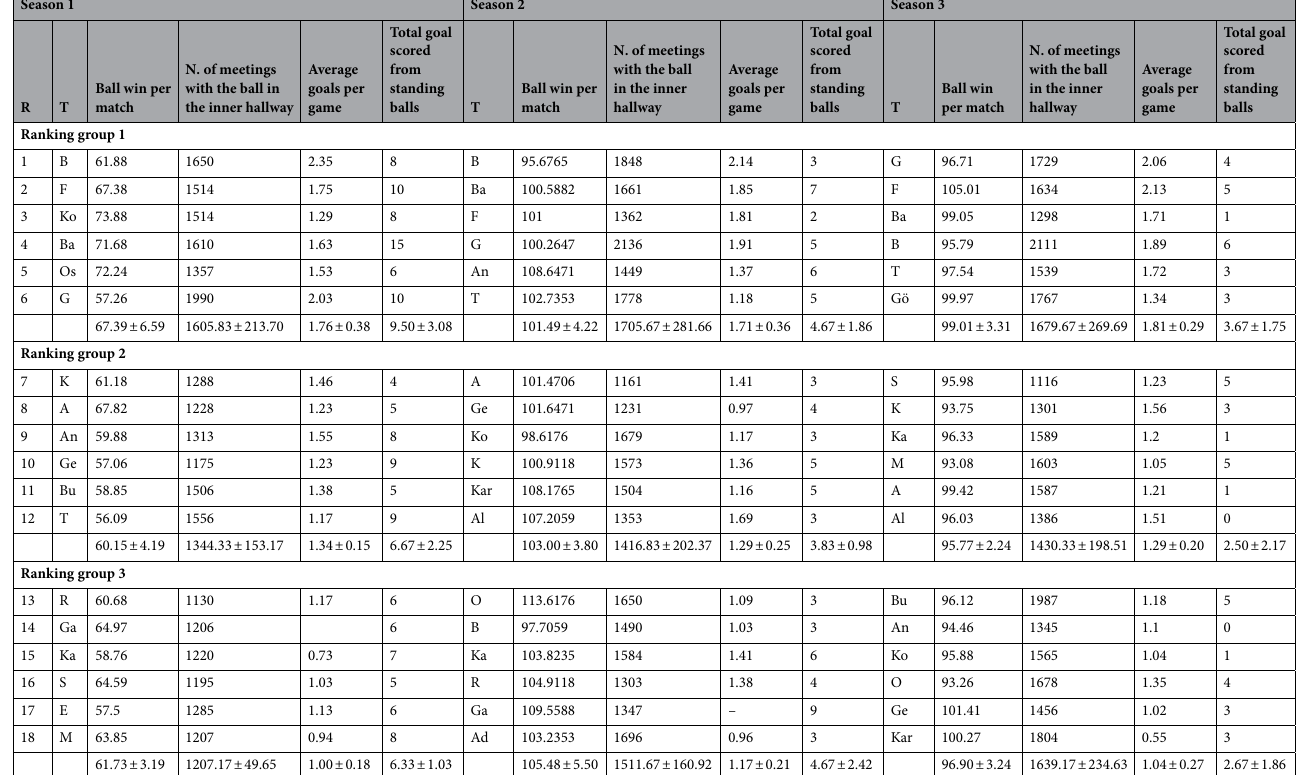
ranking group and season condition, F (2.4) = 2.33, p = 0.07, η 2 = 0.17, were not significant (Fig. 21). In a refer- ence to main effect of season condition, pairwise comparisons not showed significant differences between the season 1 and season 2, t (17) = 0.00, p = 1, d = 0. However, data revealed significant differences between the season 1 and season 3, and between season 2 and 3, t (17) = 2.54, p = 0.02, d = 0.82, and (17) = 2.62, p = 0.01, d = 0.83, respectively. Another two-way mixed ANOVA with ranking group means freekick goal scored did not reveal any effect or interaction significative, thus, the main effect of season condition, the interaction between rank- ing group and season and the ranking group showed: F < 1, (2.4) = 2.96, p = 0.07, η 2 = 0.46, and F (2.4) = 1.67, p = 0.17, η 2 = 0.12, F < 1, respectively. (Fig. 22). In this respect, a new two-way mixed ANOVA with ranking group means penalty scored did not showed significant main effects of ranking group condition, F < 1, and in neither in the season condition, F (2.4) = 4.00, p = 0.06, η 2 = 0.29. However, data revealed an interaction between rank- ing group and season, F (2.4) = 3.53, p = 0.01, η 2 = 0.23. (Fig. 23). Last, a two-way mixed ANOVA with ranking group means freekick goal scored from throw-in showed not significant differences in main effect of ranking group condition, (2.4) = 4.00, p = 0.11, η 2 = 0.66, and neither in the season condition and the interaction between ranking group and season, F < 1. Technical data of the player during the match [Goal from a corner. Freekick goal scored. Penalty scored and Goal scored from throw-in (mean and SE)] as a function of ranking group and season condition are shown Table 5. Finally, another two-way mixed ANOVA with ranking group means cross the ball %, revealed a significant main effect of season condition, F (2.4) = 11.31, p = 0.001, η 2 = 0.83. In season 1 and 3 the values were higher than in Season 2. Pairwise comparisons showed significant differences between the season 1 and season 2, t (17) = 3.94, p = 0.001, d = 1.33, and, between season 2 and season 3, t (17) = − 3.78, p = 0.001, d = 0.16. In this line, comparison between season 1 and 3 did not reveal significant differences, t (17) = 0.53 p = 0.59, d = − 1.21. The main effect of ranking group condition and the interaction between ranking group and season condition were not significant, F (2.4) = 1.33, p = 0.35, η 2 = 0.40, and F (2.4) = 1.12, p = 0.35, η 2 = 0.09 (Fig. 24). Another two-way mixed ANOVA with ranking group means dribbles per match revealed a significant main effect of ranking group condition, F